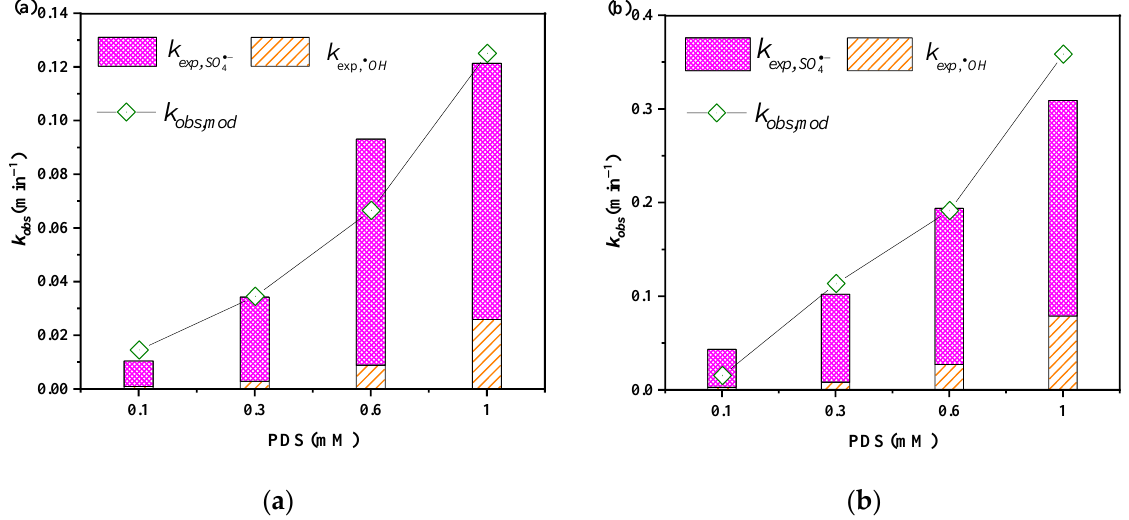
Figure 2. Effects of PDS dosage on the radical contributions and k obs of ACY ( a ) and ATL ( b ) in UV/PDS process. Conditions: [ACY] 0 = 0.022 mM, [ATL] 0 = 0.019 mM, [PDS] 0 = 0.6 mM, pH = 6.0. Table 1. [ • OH] ss and [SO 4 •− ] ss in UV/PDS process at different PDS dosages and pHs.